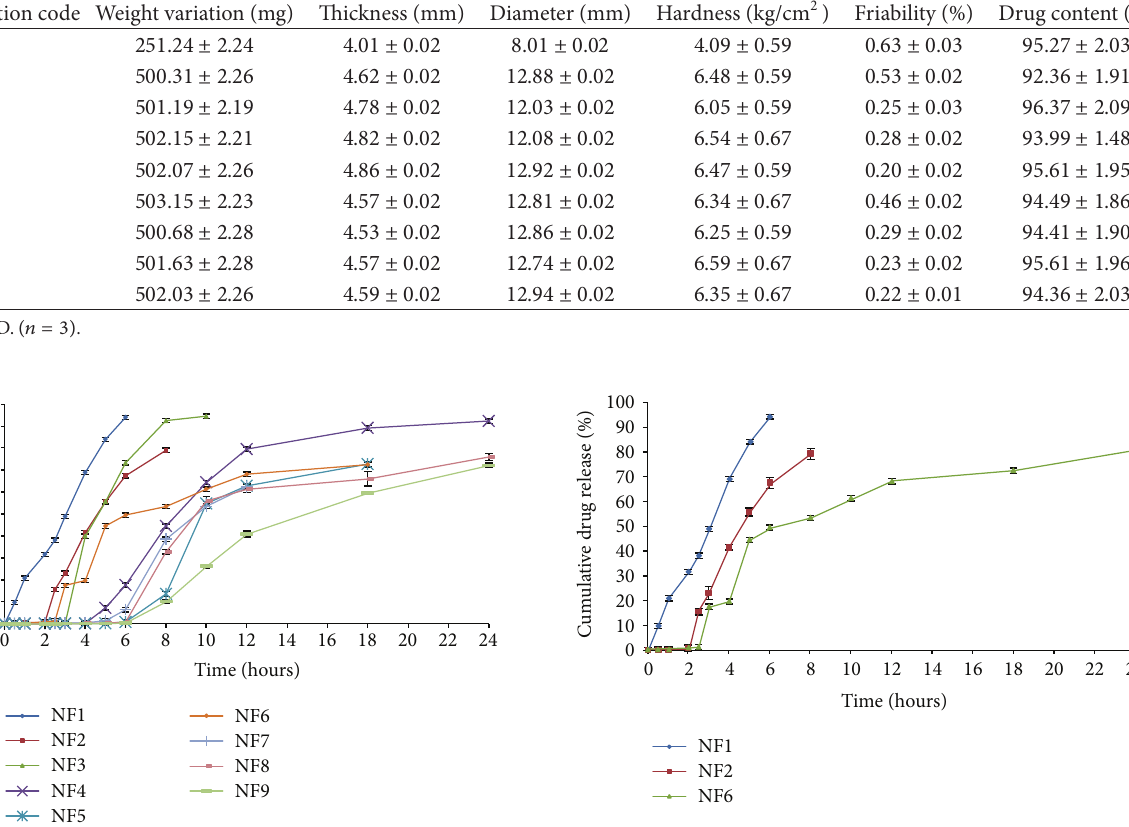
Figure 2: In vitro release profiles showing the cumulative percent of naproxen sodium release from core (NF1), press-coated tablets (NF2, NF6), and Eudragit S-100 coated tablets (NF3, NF4, NF5, NF7, NF8, and NF9) without rat caecal content. Data are expressed as mean ± S.D. ( 𝑛 = 3 ).